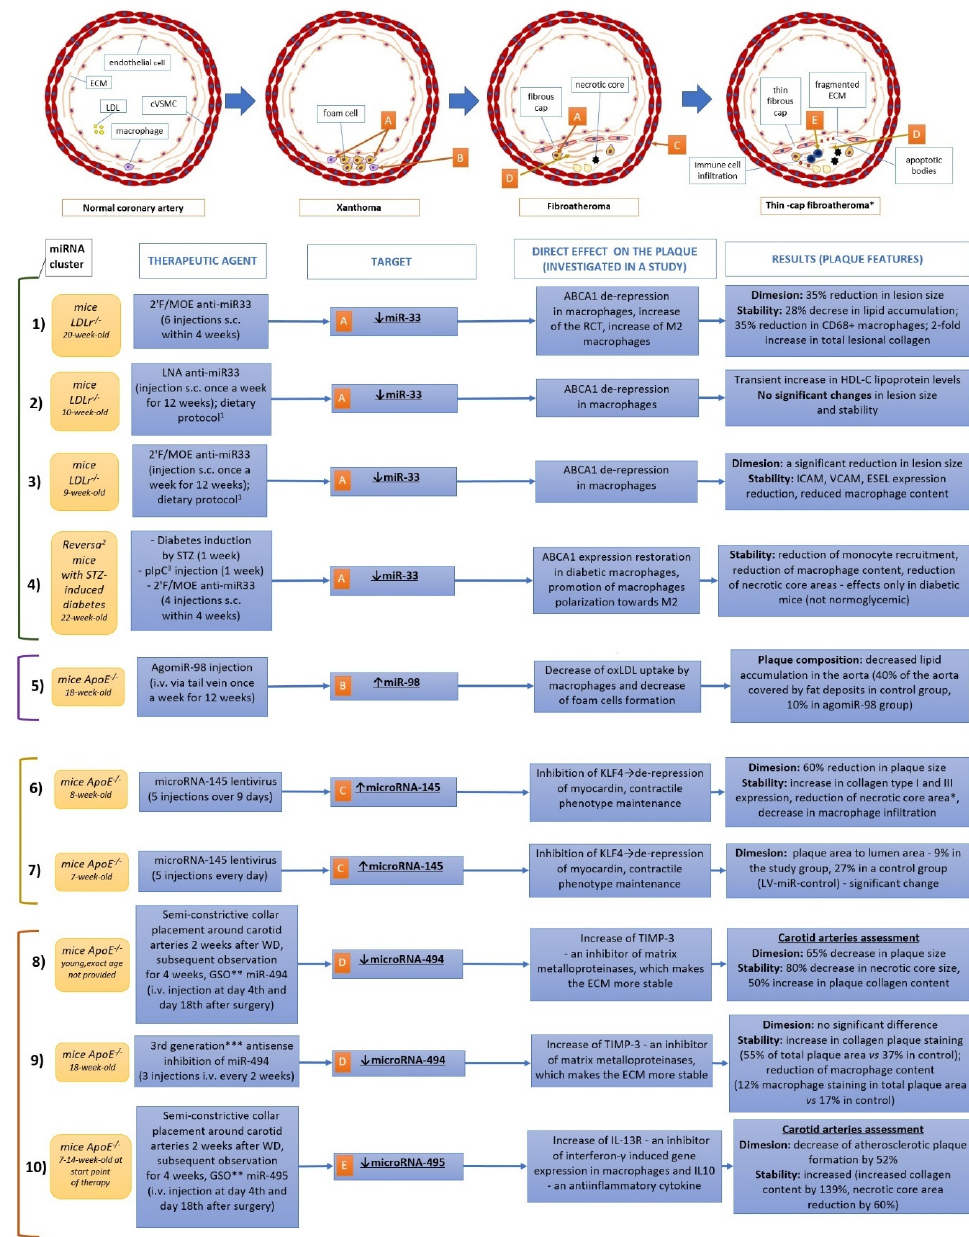
Figure 2. Examples of therapies targeted at ncRNA. Studies: ( 1 ) target miR-33 [82]; ( 2 ) target miR-33 [83]; ( 3 ) target miR33 [84]; ( 4 ) target miR-33 [43]; ( 5 ) target miR-98 [45]; ( 6 ) target miR-145 [59]; ( 7 ) target miR-145 [85]; ( 8 ) target miR-494 [86]; ( 9 ) target miR-494 [87]; ( 10 ) target miR-495 [88]. Numbers (in superscript) : 1 = different dietary protocols; in study ( 2 ), normal chow diet for 2 weeks and Western diet (21% of fat) for 10 weeks; in study ( 3 ), Western diet for 12 weeks; 2 = Reversa mice is a transgenic mice ( LdLr − / − Apob 100/100 Mttp fl/fl Mx1 - Cre +/+ ), in which hypercholesterolemia can be reversed by Cre induction and subsequent Mttp gene inactivation [89]; 3 = pipC, polyinosinic polycytidylic RNA (pIpC), an agent used for Cre induction in Reversa mice model [90]; Asterisks : * = exact percentual changes not provided in the manuscript; ** = GSO, gene silencing oligonucleotide (synonym of ASO); *** = 3rd generation ASO are ASO modified with LNA (locked nucleic acids), PNA (peptic nucleic acids), or morpholinophosphoroamidate (MF) [91]. Abbreviations: 2 ′ F/MOE = 2 ′ fluoro/methoxyethyl–modified, WD = Western diet (enriched with fat =